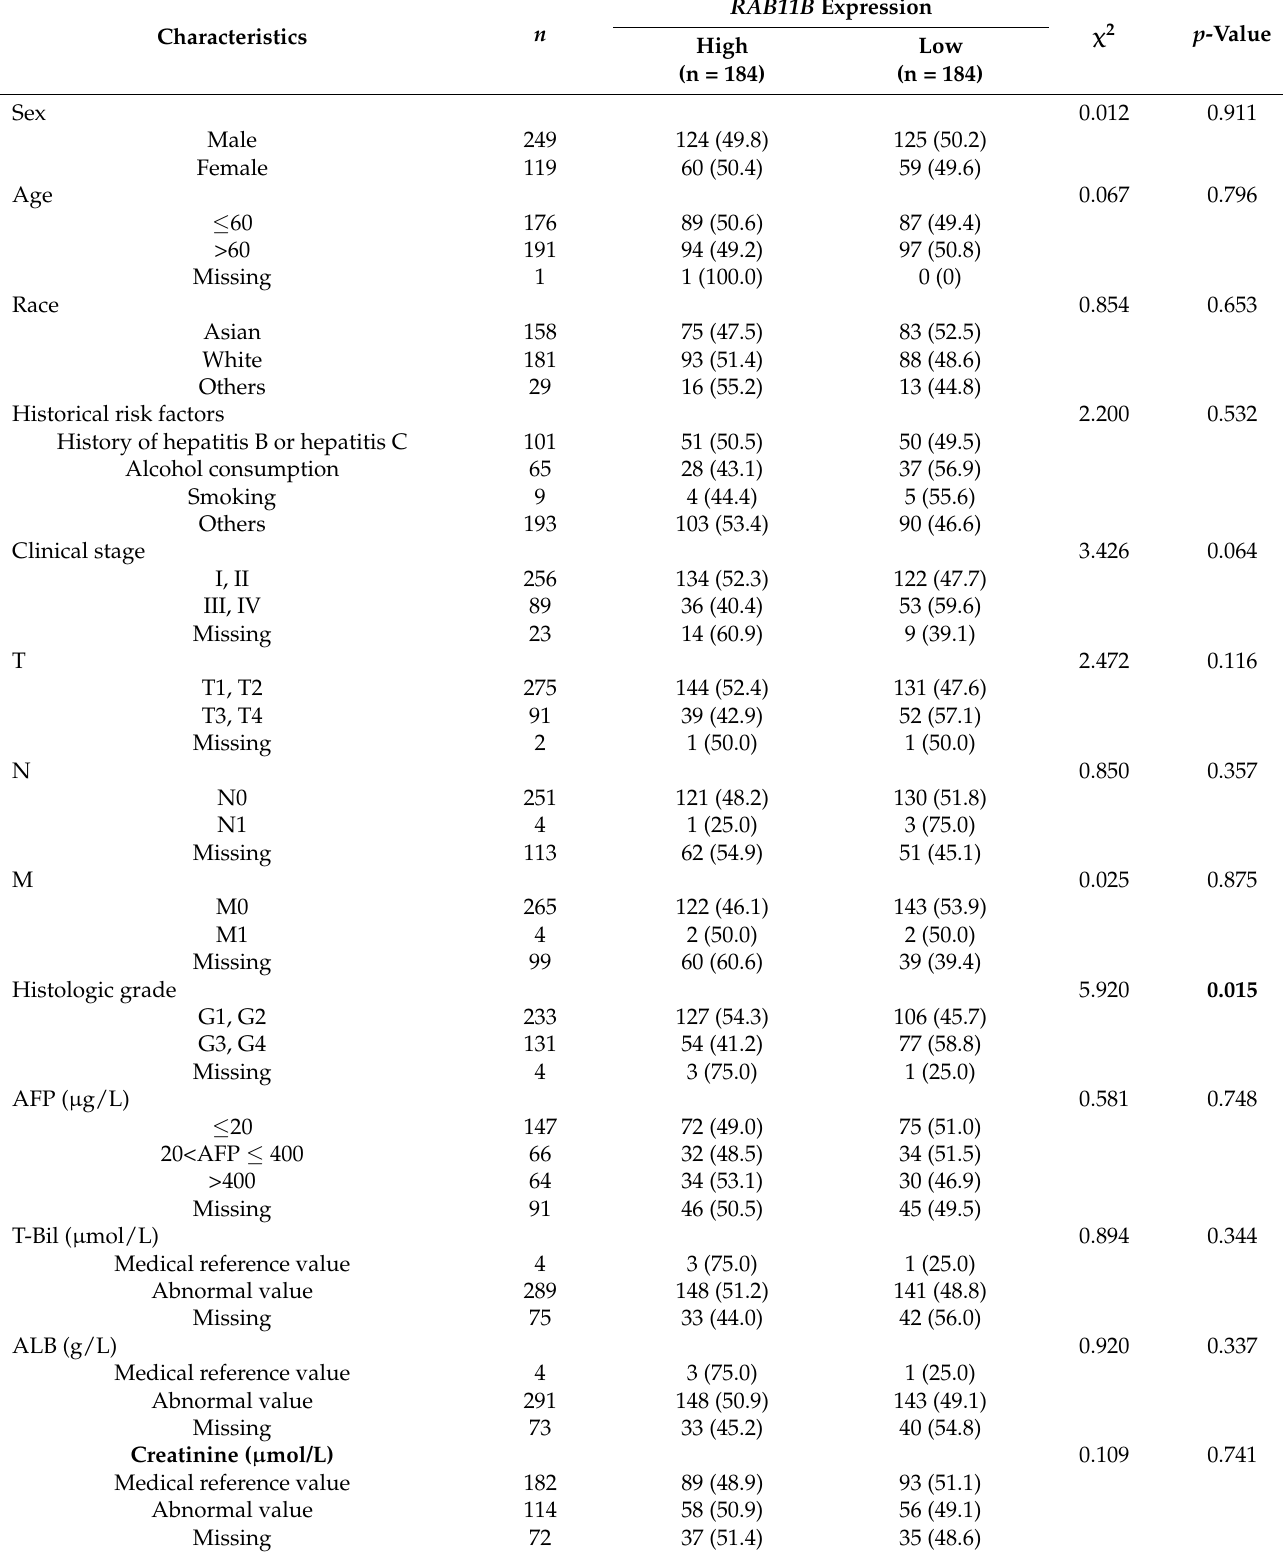
Table 2. Relationship between clinicopathological characteristics and expression of